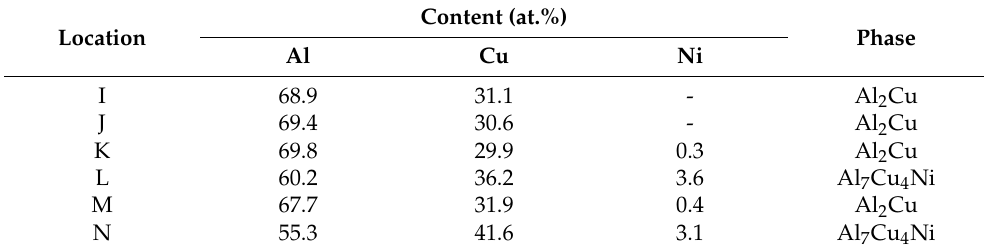
Figure 7. BSE images of the fracture surfaces of the Al/Cu dissimilar joints without alloying elements and with the addition of 2.3 at.% Ni. Table 5. Chemical compositions of the fracture surfaces indicated in Figure 7.